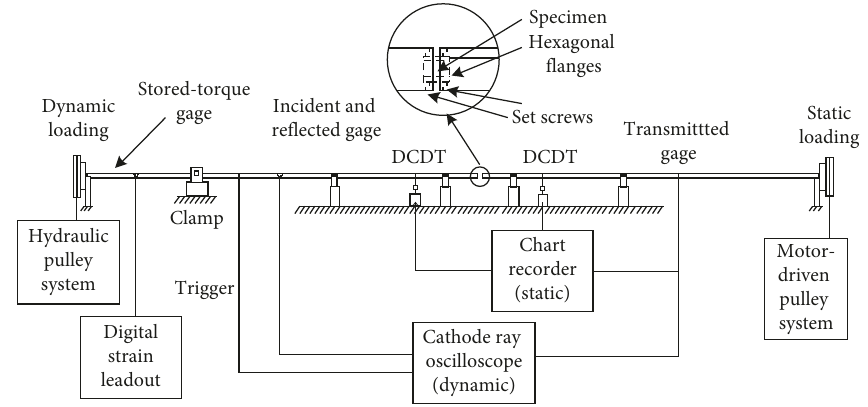
Figure 21: Schematic of a prestored energy TSHB modified for incremental strain rate experiments